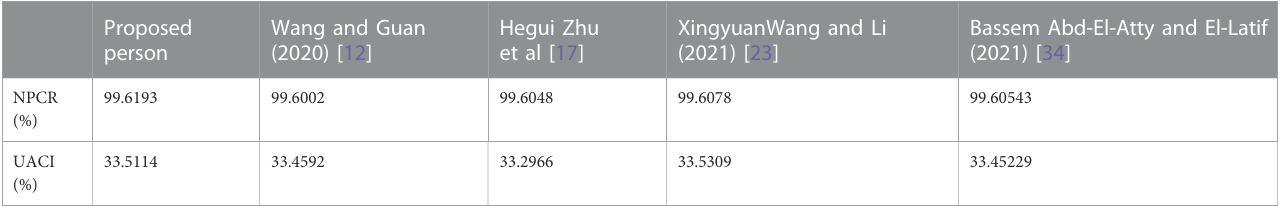
TABLE 6 Value of NPCR and UACI of different